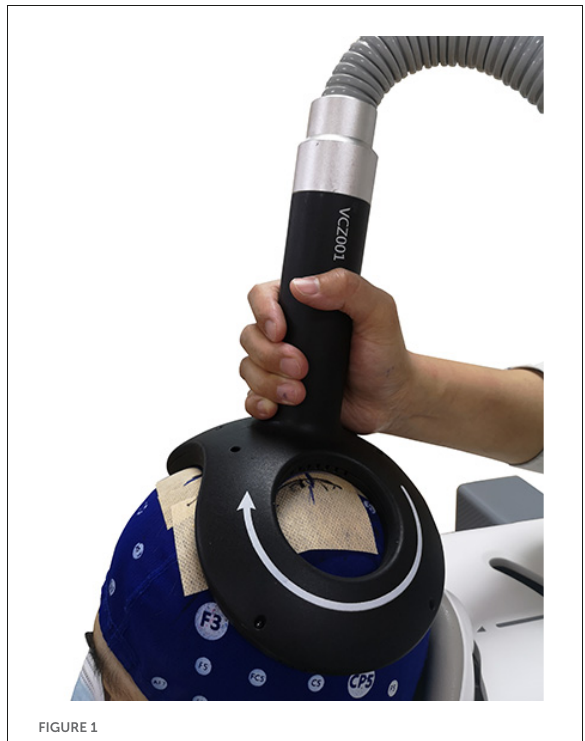
FIGURE1 Coil handle is perpendicular to the